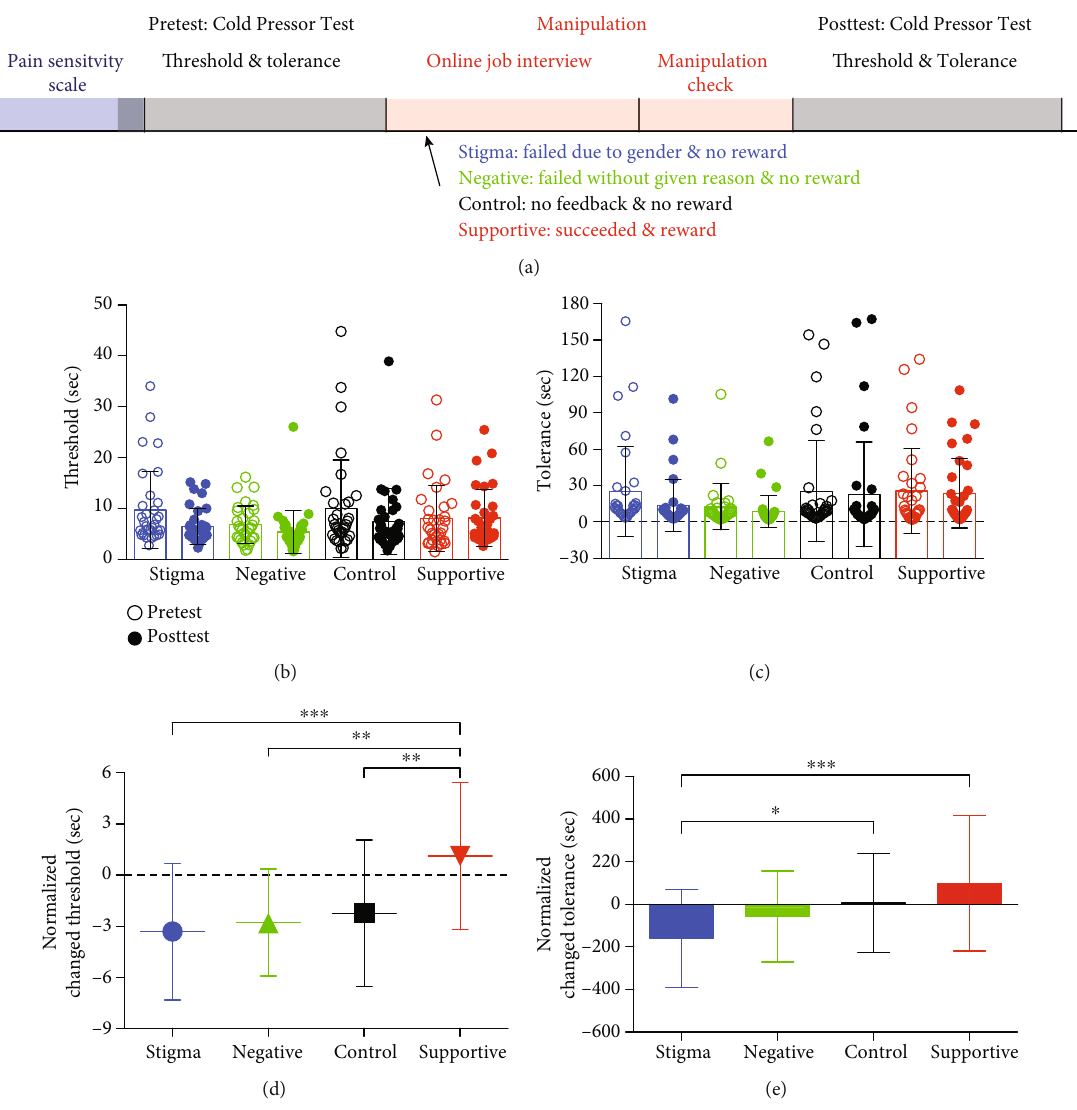
Figure 1: Experimental design and behavioral results in Experiment 1: (a) experimental design; (b) threshold in the pretest and posttest; (c) tolerance in the pretest and posttest; (d) the e ff ect of condition on pain threshold; (e) the e ff ect of condition on pain tolerance ( ∗∗∗ p < 0 : 001 , ∗∗ p < 0 : 01 , and ∗ p < 0 : 05